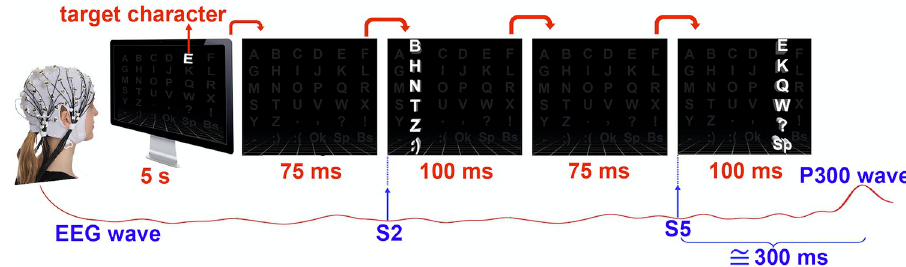
Fig 6. 3D-C paradigm steps with corresponding durations.